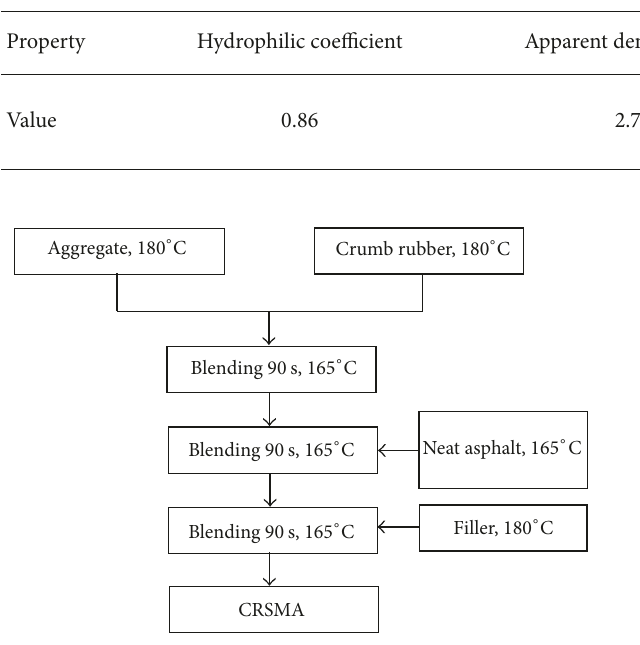
Table 4: Physical properties of mineral powder.